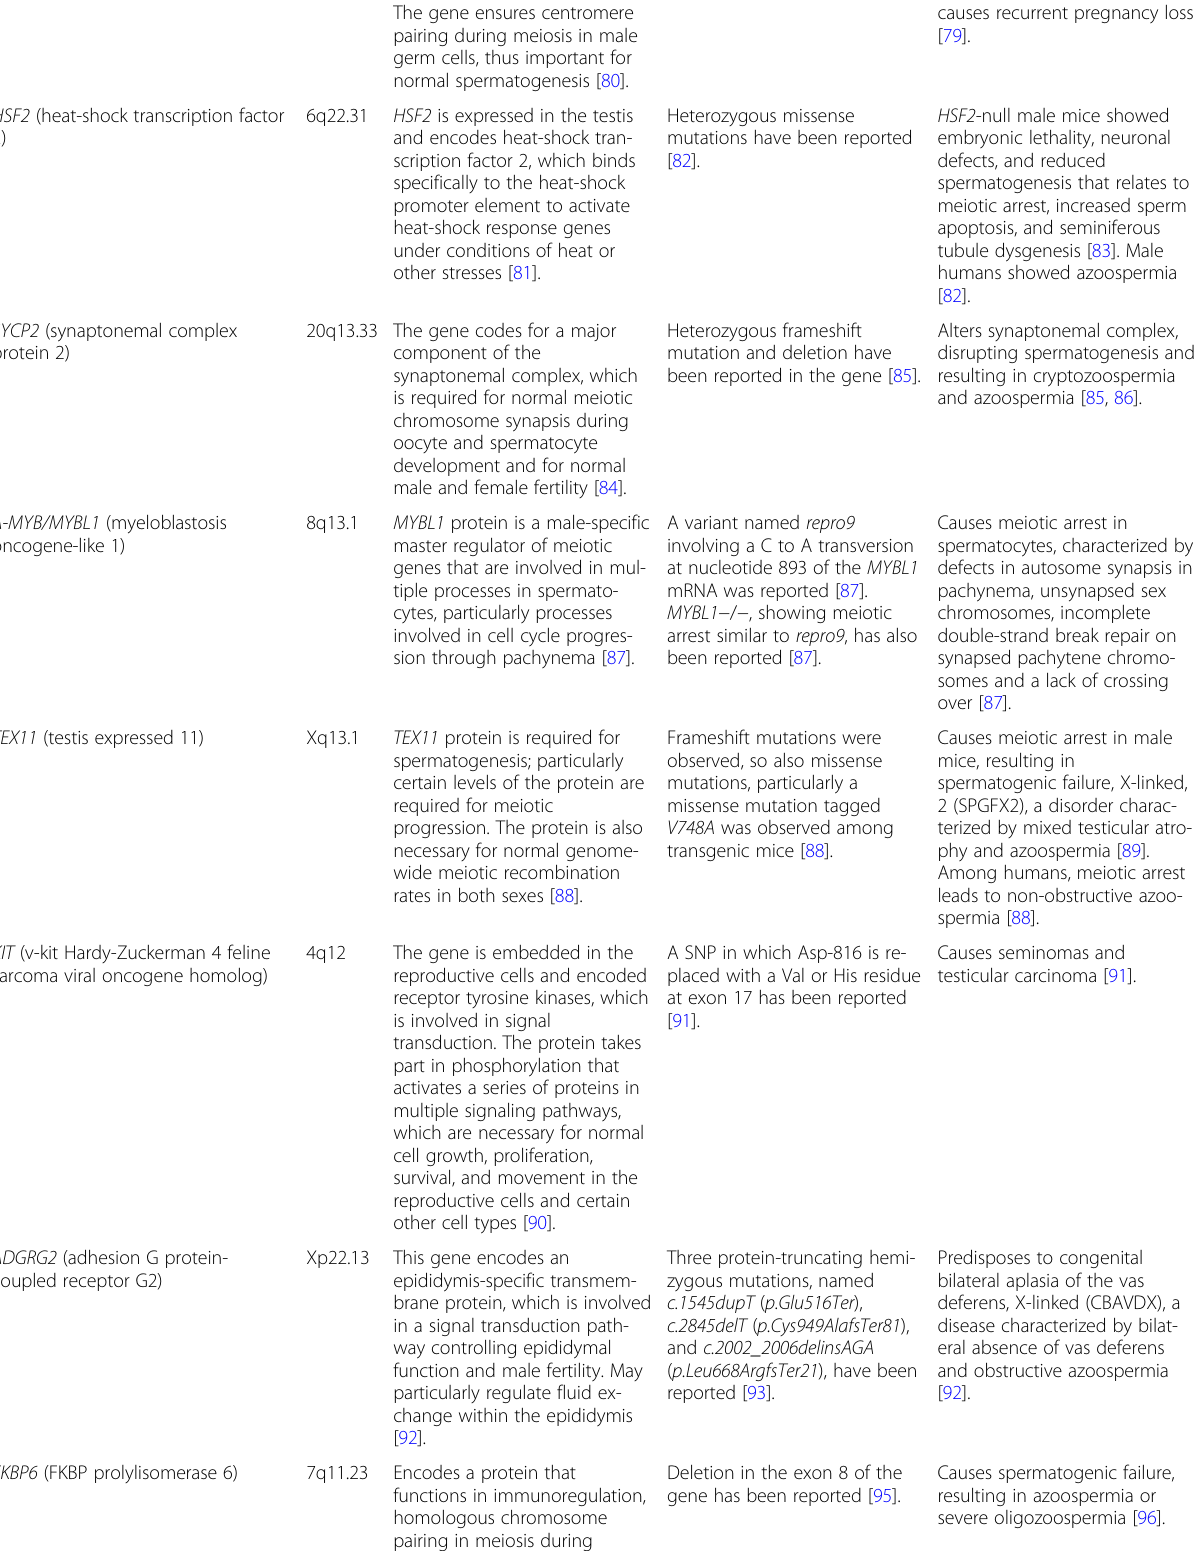
Table 2 Genes predisposing to nonsyndromic spermatogenic failure and sperm morphological abnormalities (Continued)